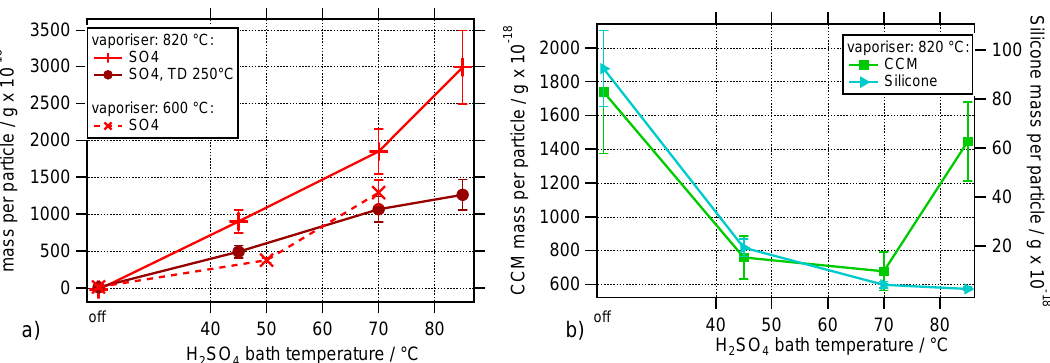
Fig. 4. Left: sulphate coating (mass per particle) as a function of the H 2 SO 4 bath temperature, detected at 600 ◦ C and 820 ◦ C vaporiser temperature. The thermodenuder (TD) operated at 250 ◦ C removes only part of the sulphate. Right: silicone and carbon containing mass (CCM) on 300nm ATD particles coated with sulphuric acid. AMS vaporiser temperature: 820 ◦ C (FROST2). Silicone is efficiently destroyed by H 2 SO 4 while a certain amount of CCM remains on the